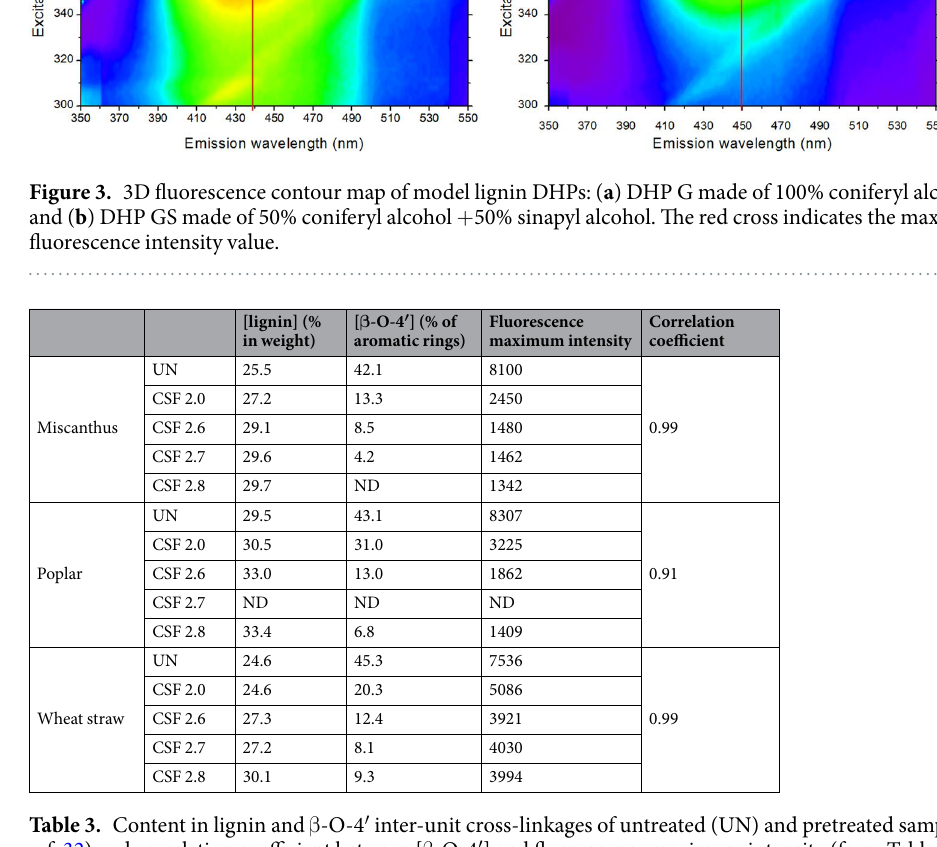
(Table 3). In particular, the β -aryl ether linkages ( β -O-4 ′ ) content was noticed to decrease with increasing pre- treatment severity. Determination of the correlation coefficient between the β -aryl ether linkage content and the fluorescence maximum intensity for each untreated and pretreated biomass sample gives a very strong positive correlation (Table 3). If this correlation seems rational based on the fact that fluorescence of plant cell wall origi-